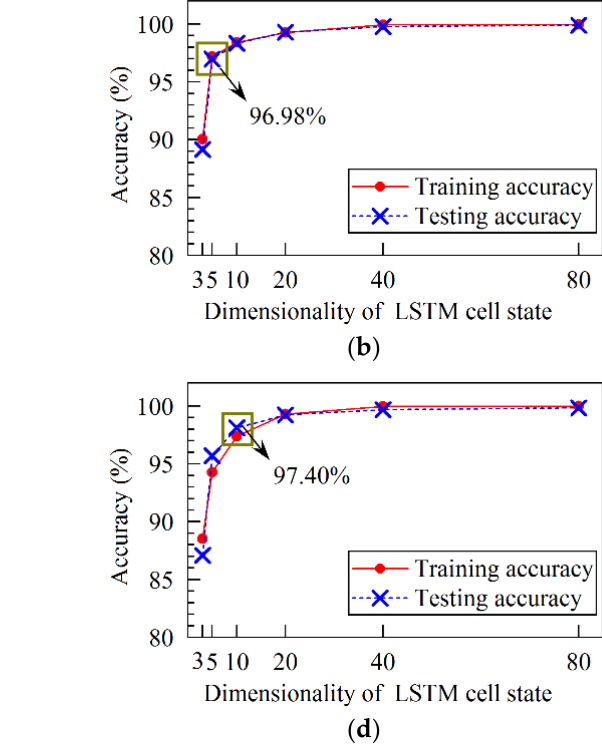
Figure 14. Training and testing accuracies of the third network structure and data division mode 1. The dark yellow circle marks the accuracy that is more than 95% with the lowest hidden element number.